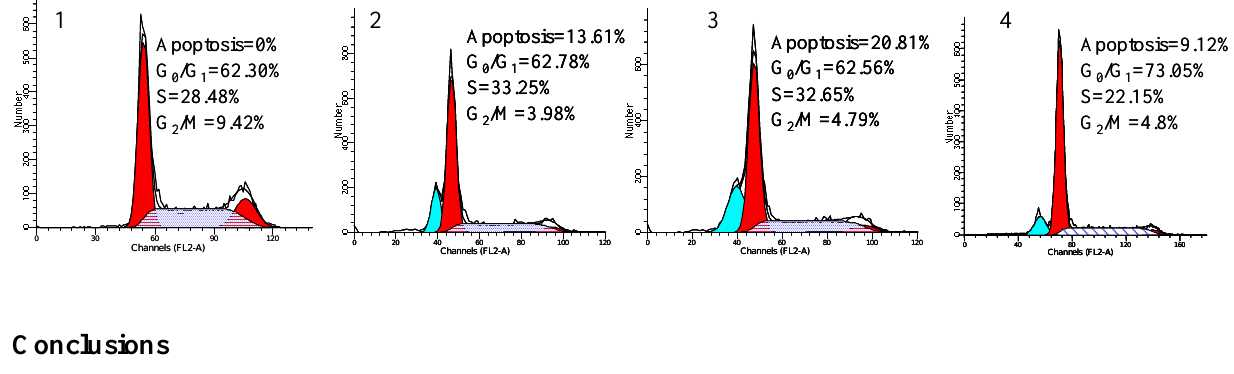
Figure 3. Flow cytometry analysis of HepG2 cells treated with two saponins. 1) HepG2 cells treated with vehicle; 2) kalopanaxsaponin A, 6 µM for 24 h; 3) kalopanaxsaponin I, 3 µM for 24 h; 4) betulinic acid, 20 µM for 24 h. Data are the results of one experiment representative of